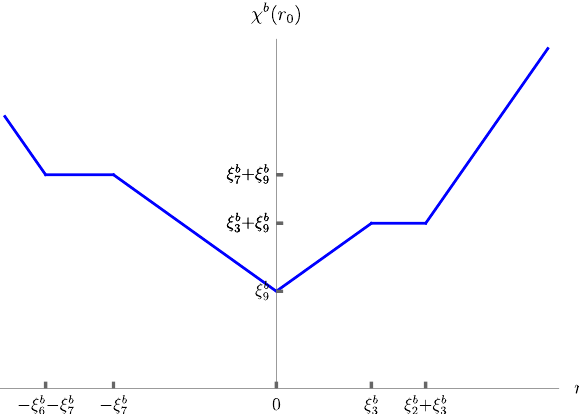
Figure 24: IIA profiles for the horizontal reduction of resolution